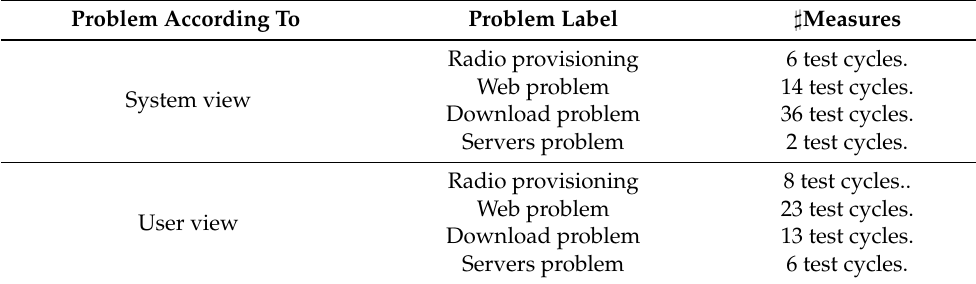
Table 8. Statistics of service problem events in the context of trace cycles